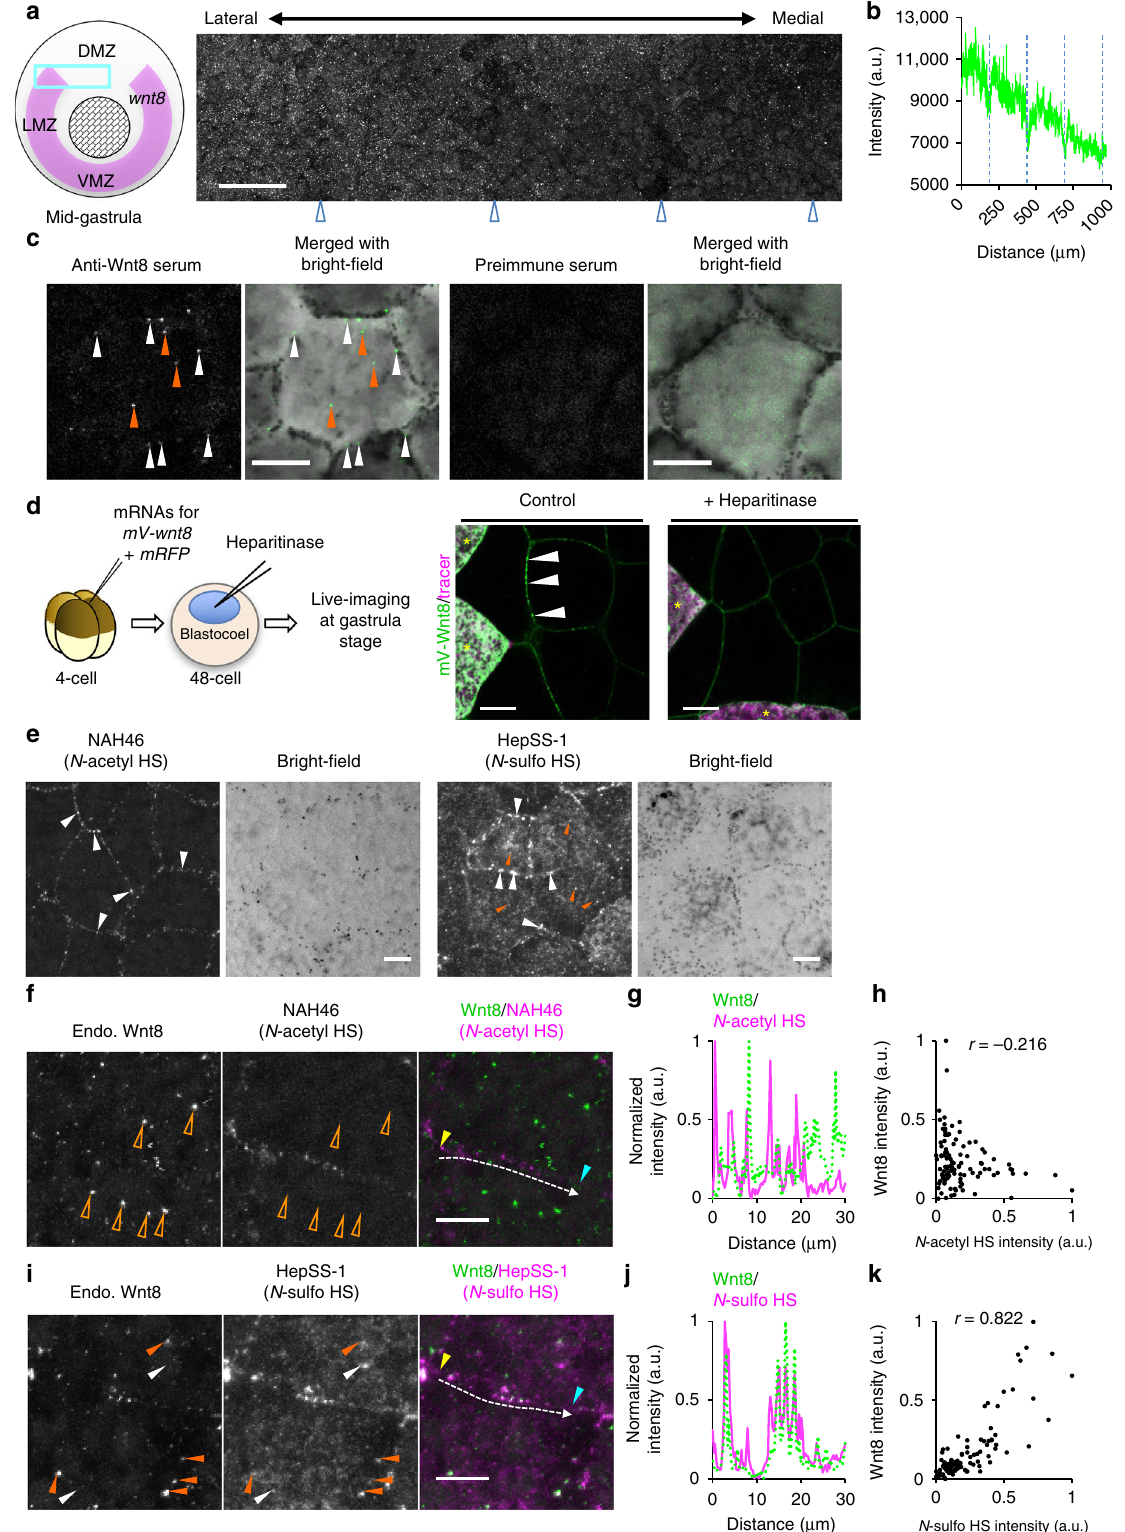
Supplementary Fig. 11g for the VMZ). Precise observations at a higher resolution uncovered that Wnt8 did not show a con- tinuous distribution but formed puncta at the cell boundary and inside the cells (Fig. 2c, left, indicated by white and orange arrowheads, respectively). This punctate staining was reduced by